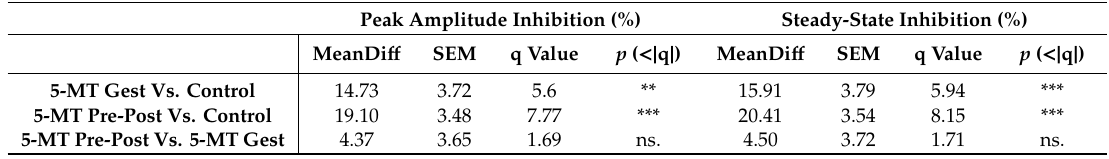
Table 1. Post-hoc comparisons among groups using the Tukey test ( p <